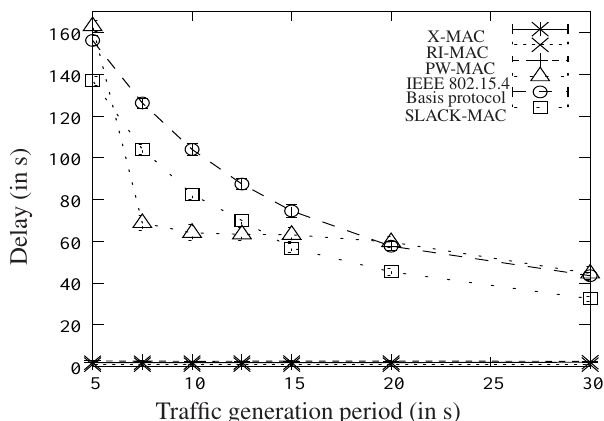
Figure 7. End-to-end delay of data packets as a function of the traffic generation period, for a duty-cycle of 1 %, and for several